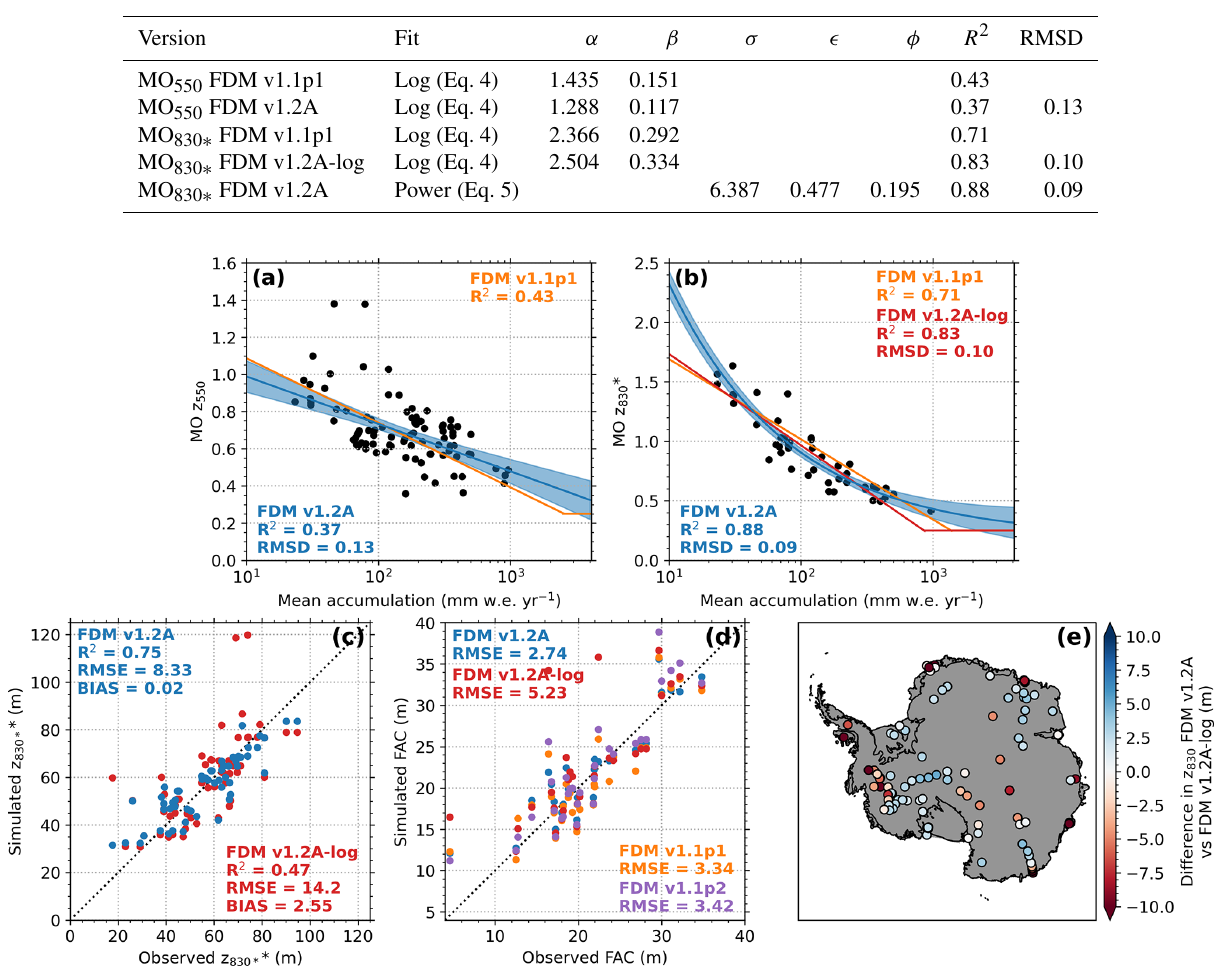
Figure 3. Scatter plots defining the MO ratios for (a) z 550 and (b) z 830 * as a function of the annual average accumulation including various MO fits. The blue-shaded areas indicate the 95% confidence intervals. (c) Scatter plots of the simulated against observed z 830 ∗ ( z 830 minus z 550 ) for FDM v1.2A and FDM v1.2A-log. (d) Scatter plots of the simulated against observed FAC for FDM v1.2A, FDM v1.2A-log, FDM v1.1p1 and FDM v1.1p2. (e) Map of the difference between simulated firn thickness ( z 830 ) of the two tests (FDM v1.2A vs. FDM v1.2A-log) for locations with observations. The statistics and fits of the MO fits are listed in Table